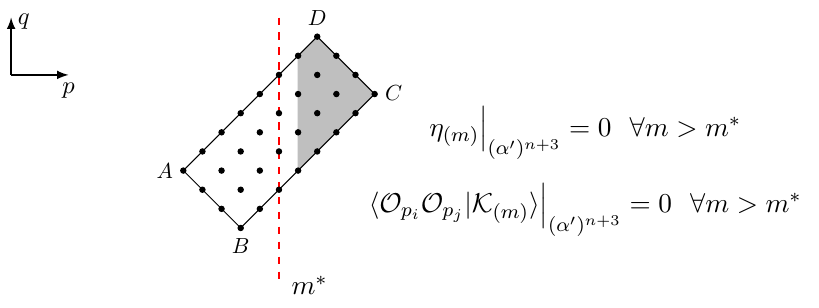
Figure 1 . The rectangle R ~τ of operators K pq which are degenerate at leading order. The lifting in supergravity is only partial with the anomalous dimension depending only on the column. At order ( α 0 ) n +3 we impose that the CFT data of the operators in the grey area are